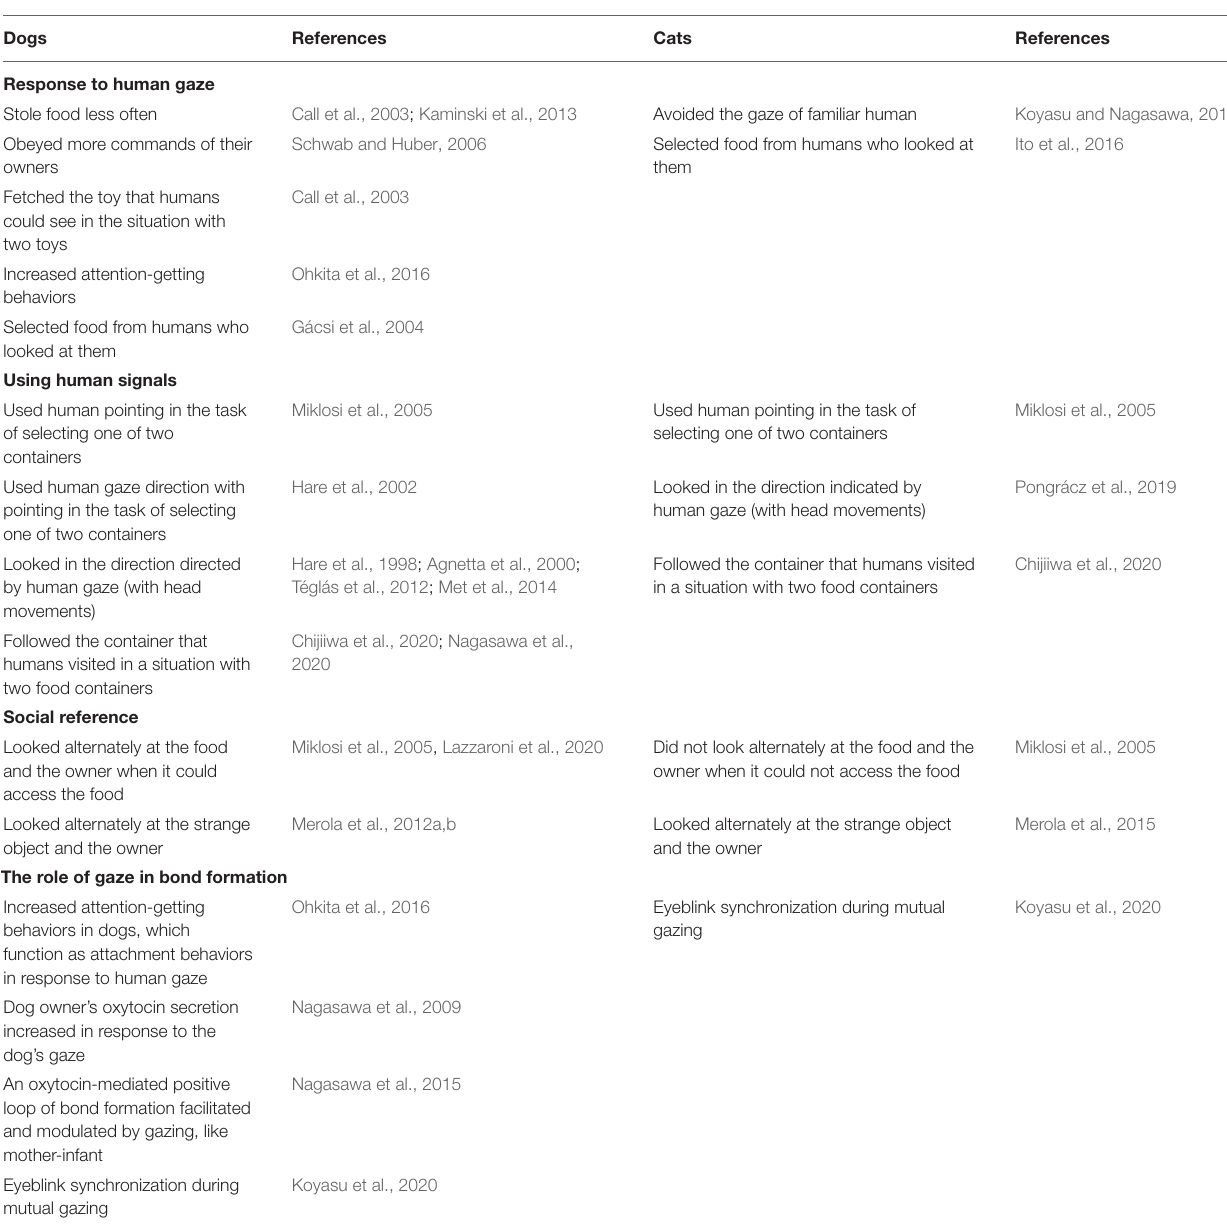
TABLE 1 | Gaze communication between dogs/cats and humans.